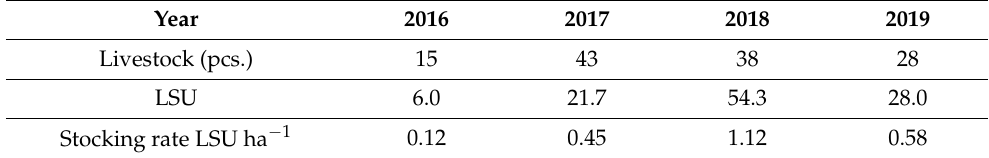
Table 3. Animal stocking rate in each year of the study. LSU (livestock unit): cattle under one year old = 0.4 LSU; from 1 to less than 2 years old = 0.7 LSU; male cattle 2 years old and over = 1.0